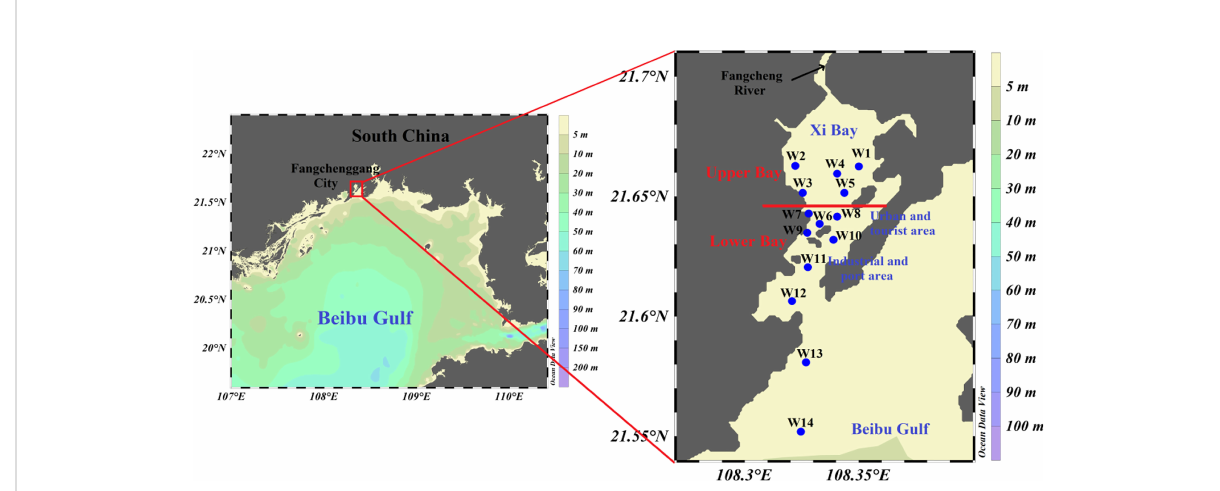
FIGURE 1 Map of the study area and sampling stations in Xi Bay (upper bay: W1 – W5; lower bay: W6 –